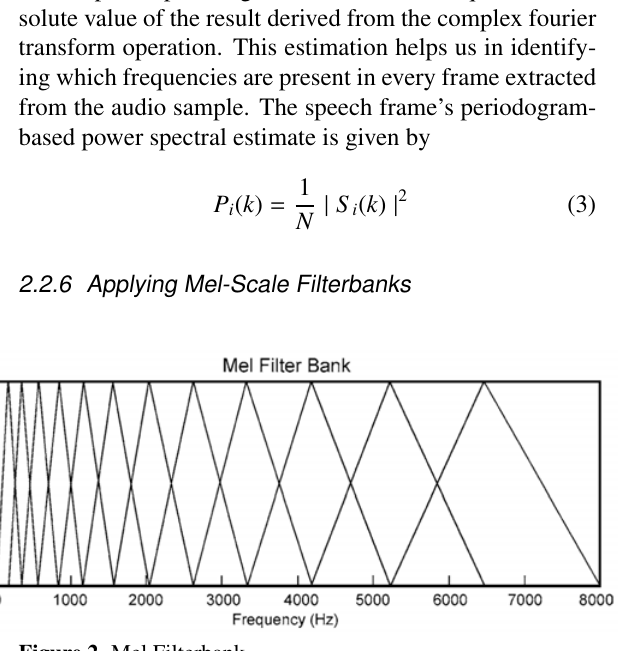
Figure 2. Mel Filterbank Figure 3. Classifier Model